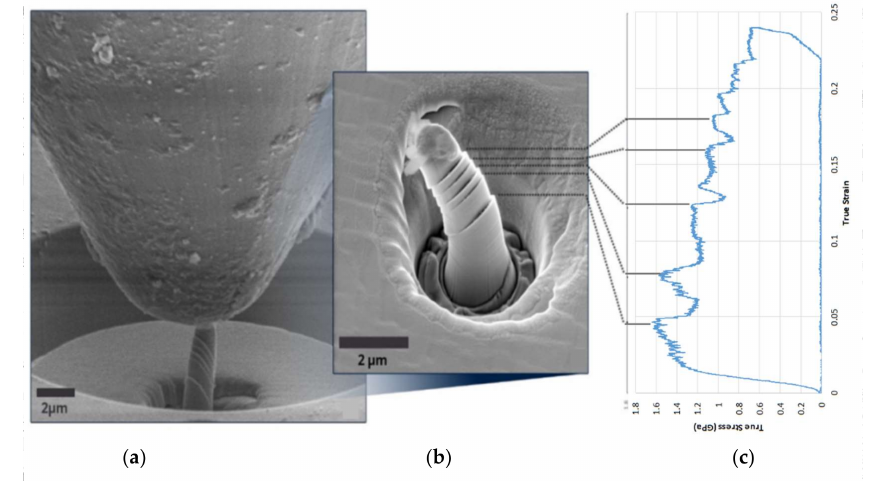
Figure 3. A typical experimental result set: ( a ) a frame taken from a video recorded by SEM at 70 ◦ tilt during the compression test of a micro-pillar, showing the large flat-tip indenter at the top, with FIB-machined micropillar within a circular well (bottom middle) undergoing parallel crystal slip; ( b ) zoom of high-resolution SEM image (taken at 30 ◦ tilt angle) of a micro-pillar after compression; ( c ) true stress and strain curve of the pillar, with individual stress drops associated with the corresponding distinct slip bands.